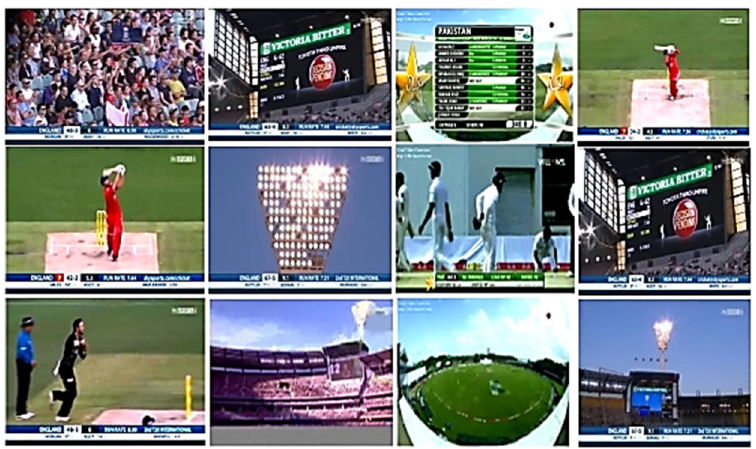
Figure 3. Some sample frames from positive and negative class.